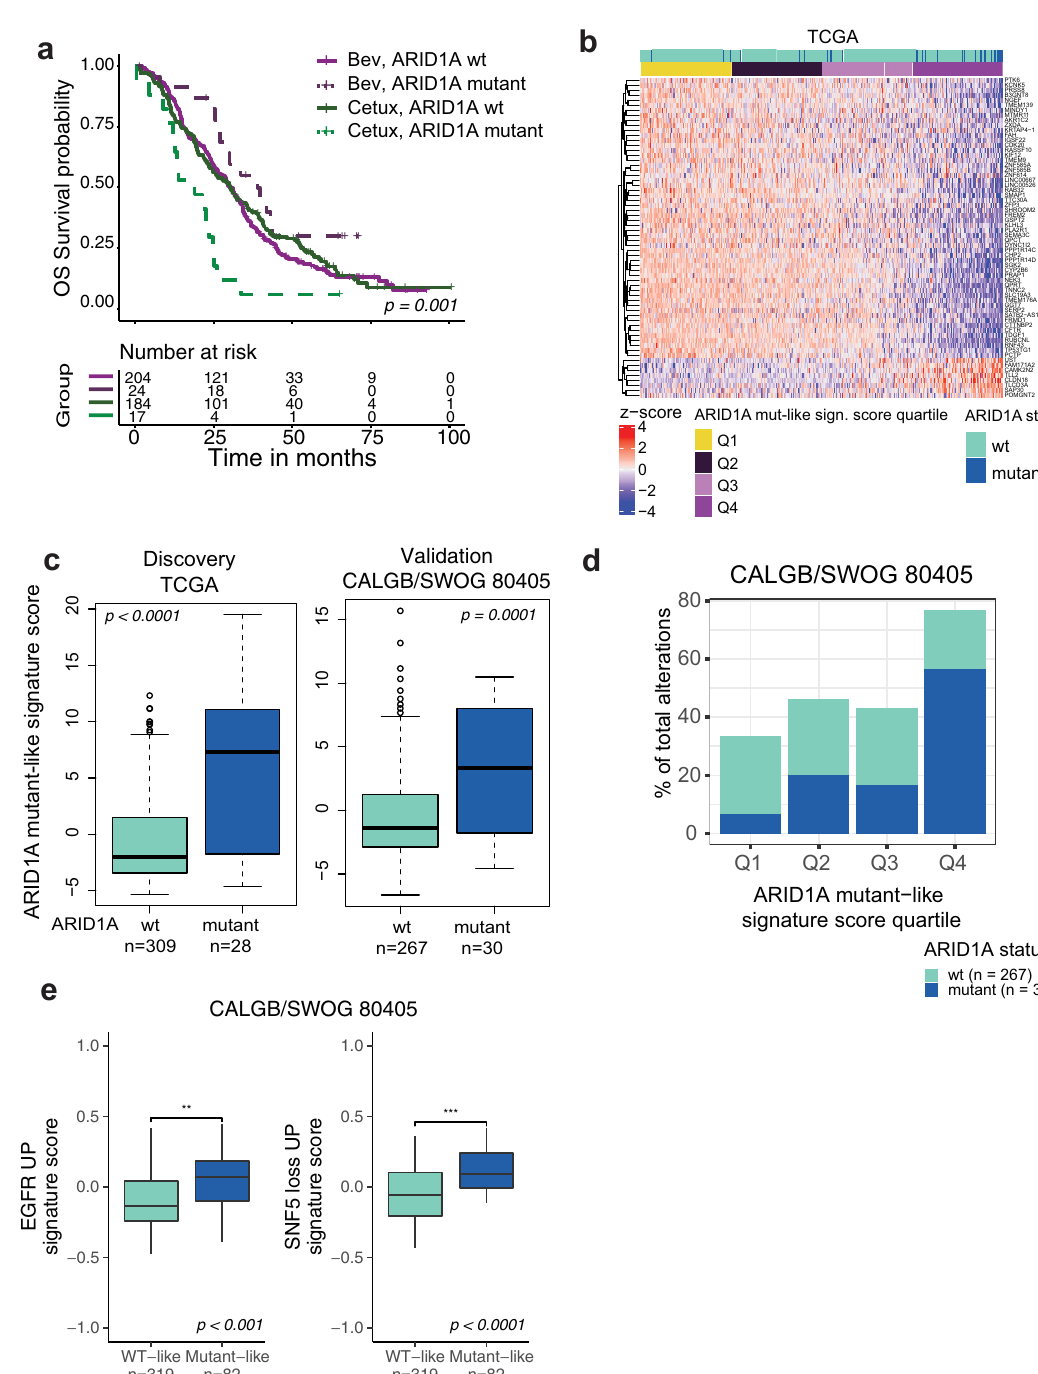
Fig. 2 | ARID1A mutations confer poor outcome to cetuximab relative to bev- acizumab possibly by partially inducing an EGFR transcriptional program. a Kaplan – Meier curves showing OS for 429 CALGB/SWOG 80405 patients with archival tissue available for targeted sequencing 24 , strati fi ed by ARID1A mutation status and treatment arm. Patients with ARID1A alterations classi fi ed as known or likely were considered mutant. p -values from log-rank test shown. b Heatmap representation of the ARID1A mutant-like signature in 578 CALGB/SWOG 80405 patientswith gene expression data. c Distributionofthe ARID1A signaturescorein the discovery TCGA cohort and validation cohort CALGB/SWOG 80405 cohort strati fi ed by ARID1A mutation status. p -values determined by two-sided Wilcoxon